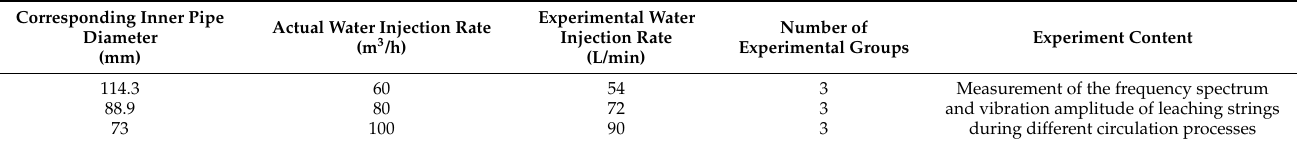
Table 4. Experimental working conditions for direct and reverse circulation with different water injection